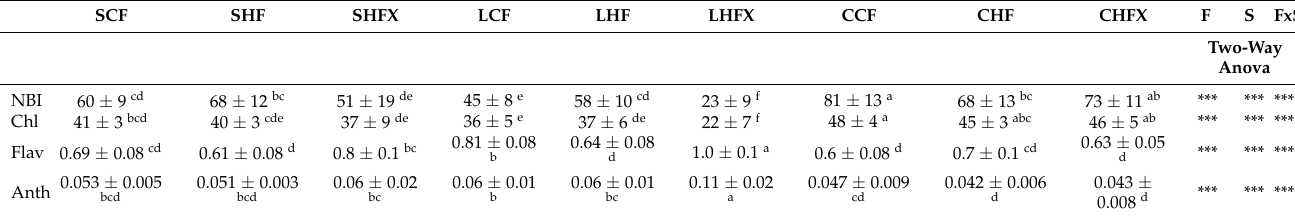
Table 4. Dualex indices of Nitrogen Balance Index (NBI), chlorophylls (Chl), flavonols (Flav) and anthocyanins (Anth) of Capsicum annum L. grown in the sandy loam (S), clay loam (L) and clay (C) soils using the nutrient solutions: conventional fertilization (CF), MCT ® fertilizers (HF) and MCT ® fertilizers plus TX (HFX). Data are presented as the mean ± standard deviation ( n = 3). Two-way ANOVA was performed to evaluate the effect of fertilization (F) and soil (S) and their interaction. SCF SHF SHFX LCF LHF LHFX